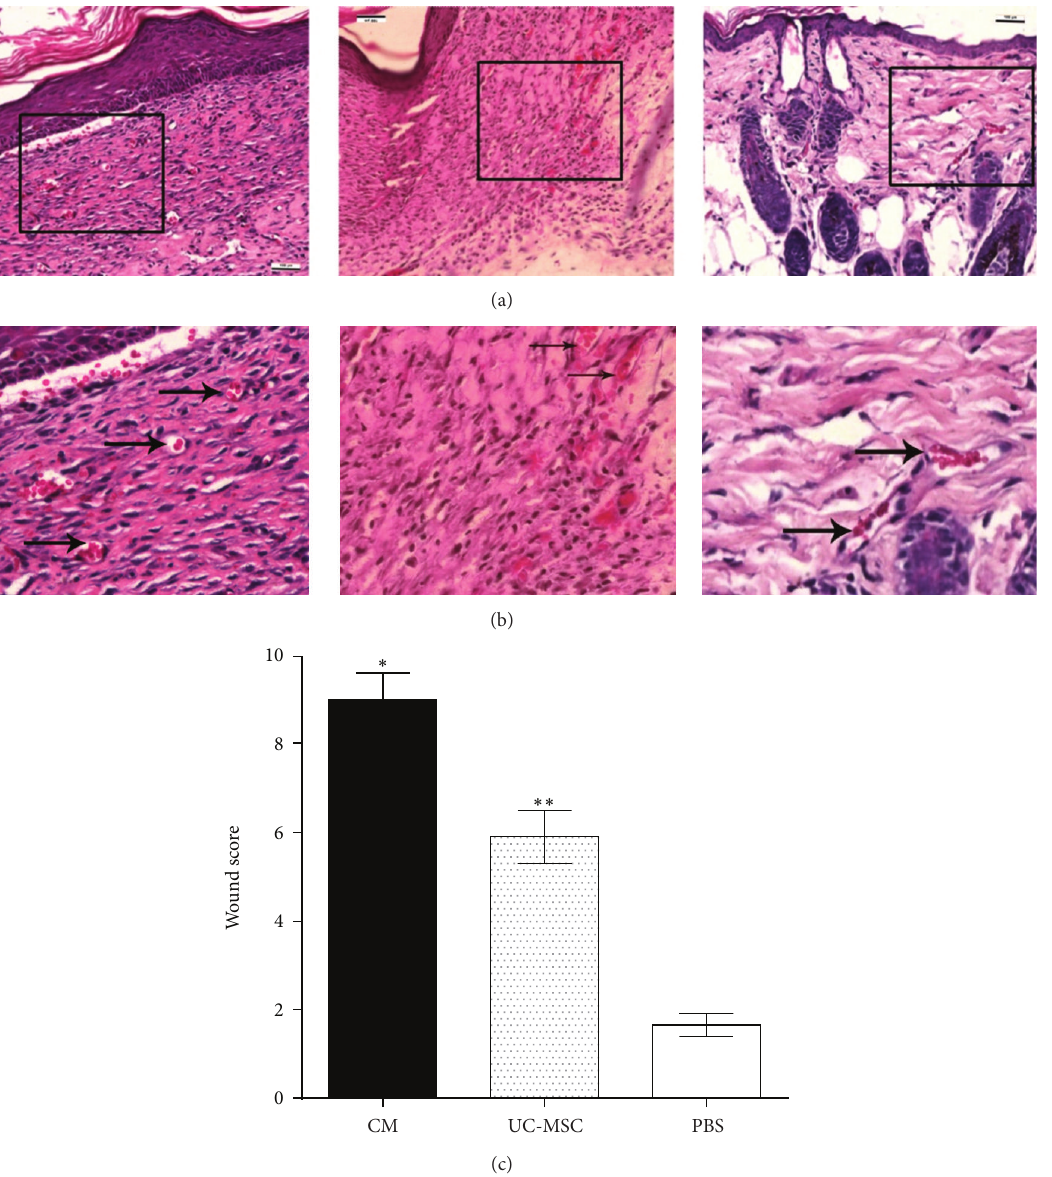
Figure 2: Histological analysis of day-14 wounds in db/db mice. Scale bar is 100 𝜇 m. (a) H and E stained images of CM-, UC-MSC- and PBS- injected tissues from left to right, respectively (20x). (b) Magnified images of CM-, UC-MSC-, and PBS-injected tissues from left to right, respectively. (c) Wound scores at day 14 ( 𝑛 = 6 ; ∗ 𝑃 < 0.05 , CM versus UC-MSC or PBS); ( 𝑛 = 6 ; ∗∗ 𝑃 < 0.05 , UC-MSC versus